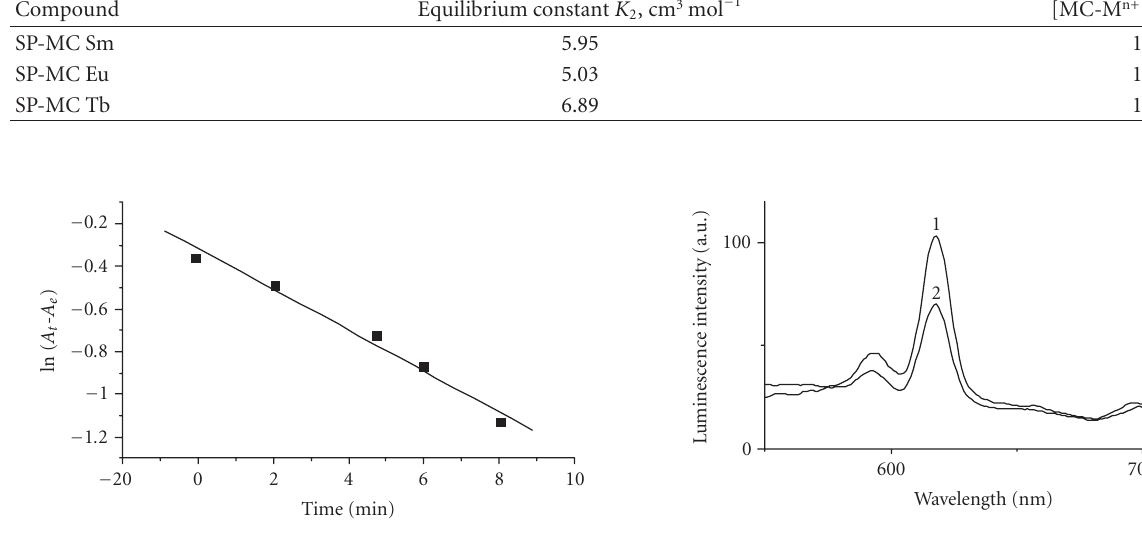
× 10 − 5 M of Eu 3+ in